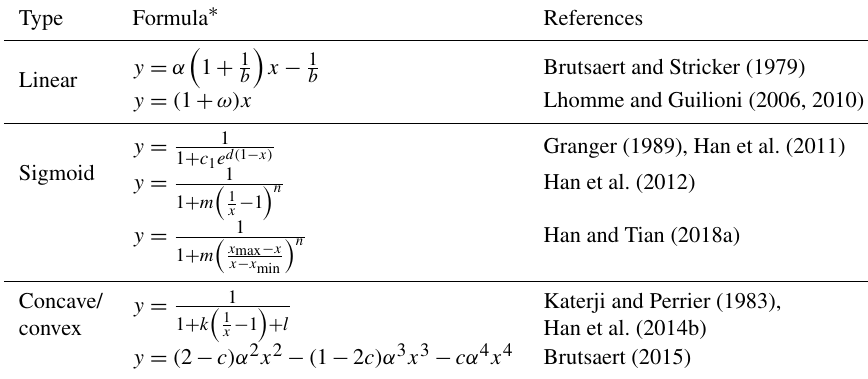
Table 2. Different analytical formulas for generalized complementary function